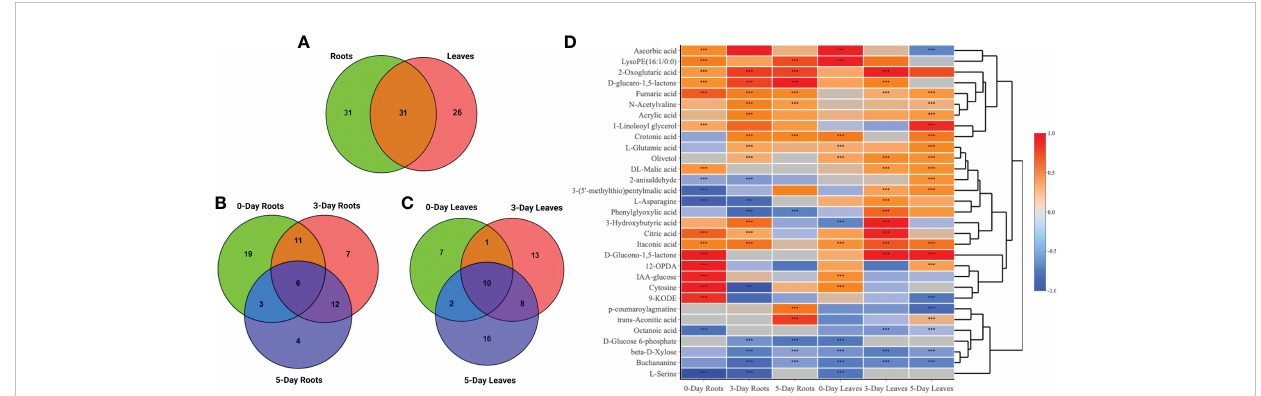
FIGURE 5 Venn diagrams and heatmap analysis. Venn diagrams showed commonalities and differences among changed metabolites in roots and leaves (A) , in roots (B) or leaves only (C) after 0, 3, and 5 days treated with the SWE. (D) A heatmap of 31 commonly identi fi ed compounds in both roots and leaf samples. The asterisks indicate signi fi cant differences (t-test and p-value <0.05) between the treated and the control